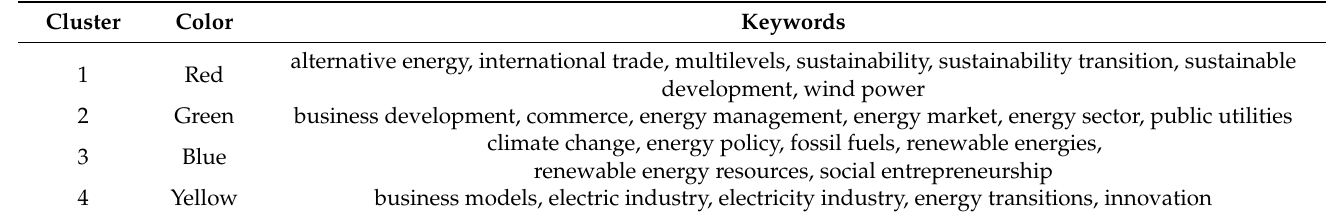
Figure 7. Bibliometric map of index keyword co-occurrence results from Scopus based on Query 19. Source: authors’ elaboration performed in VOSviewer (version 1.6.18). Table 7. Clusters of keyword co-occurrences in Figure 8 for Scopus Query 19.